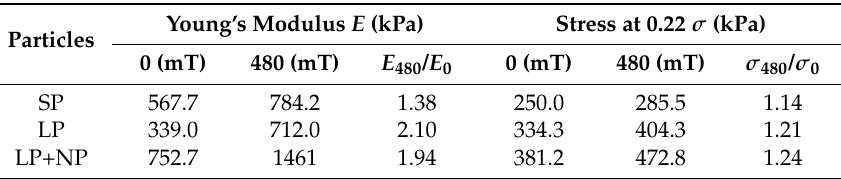
Figure 3. Strain–stress curves at 0 and 480 mT for magnetic elastomers containing ( a ) SP, ( b ) LP, and ( c ) LP+NP. Table 1. Effect of the magnetic field on the Young’s modulus and stress at a strain of 0.22 for magnetic elastomers containing SP, LP, and LP+NP.